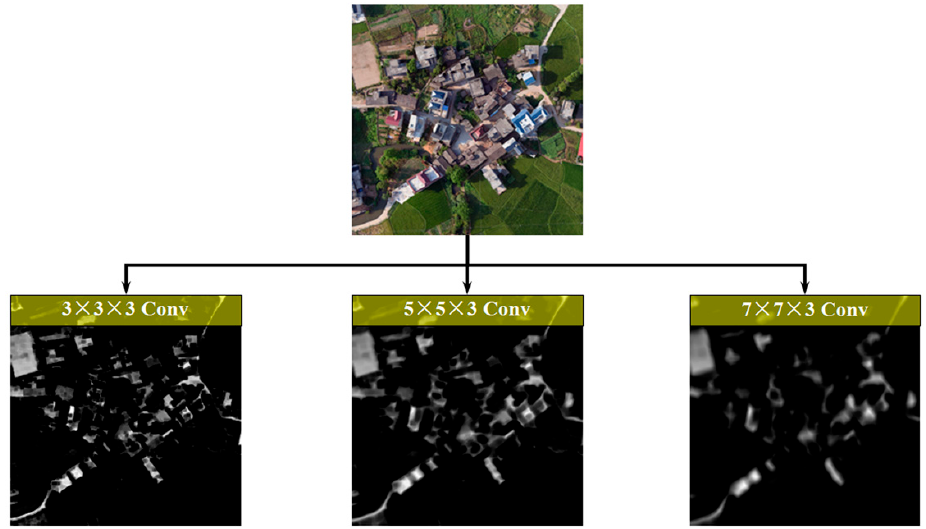
Figure 7. Example to illustrate the feature maps extracted by convolutional filters with three different sizes, which are selected from the first layer of an MSCN model.